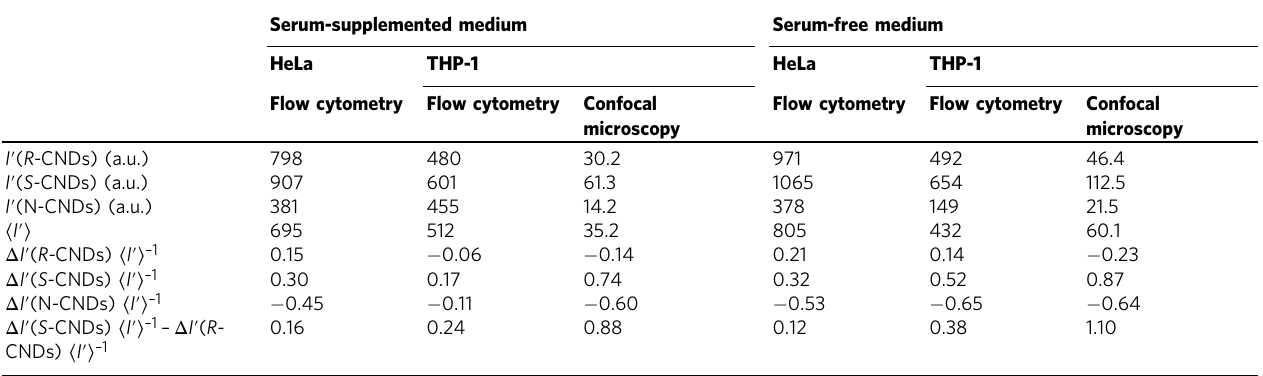
Table 3 Mean fl uorescence intensity I ′ detected per cell after t = 48 h incubation at C ′ CNDs = 400 μ g mL − 1 , corresponding to the last time point in Fig.